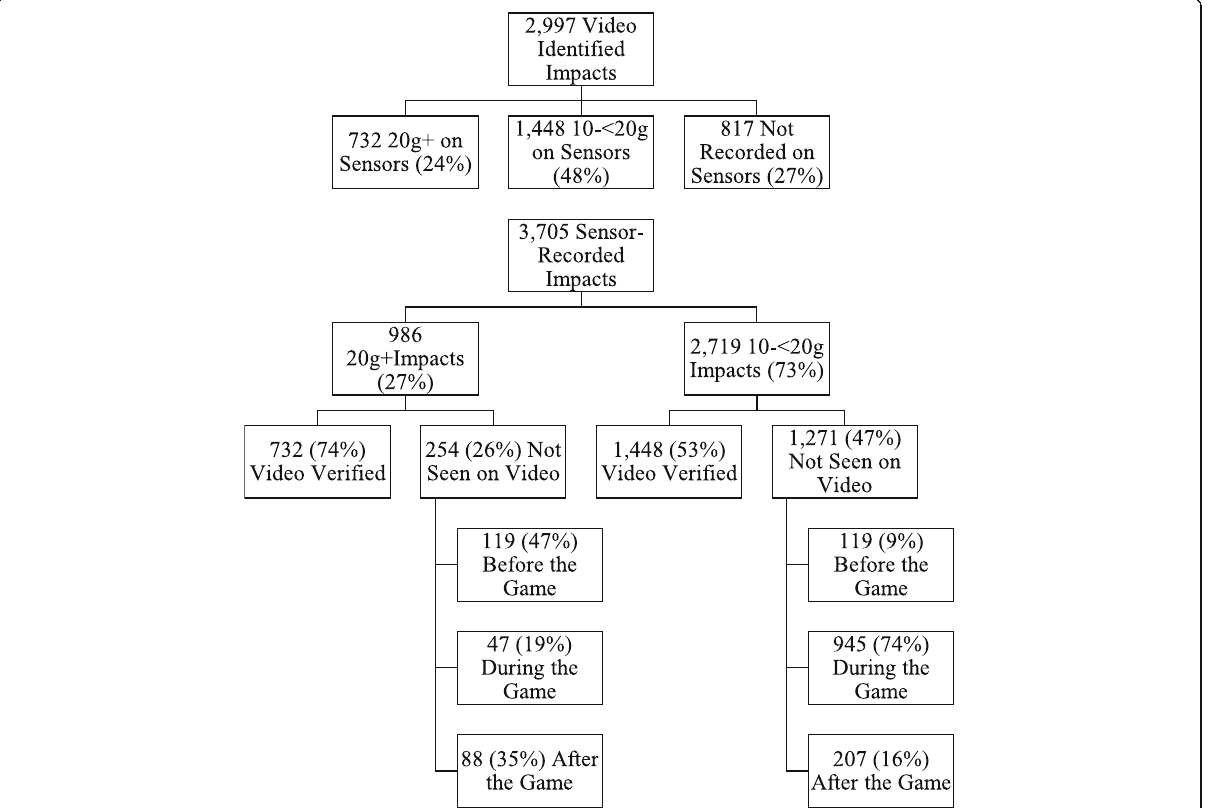
Fig. 1 Flow diagram comparison of video-identified impacts and sensor-recorded